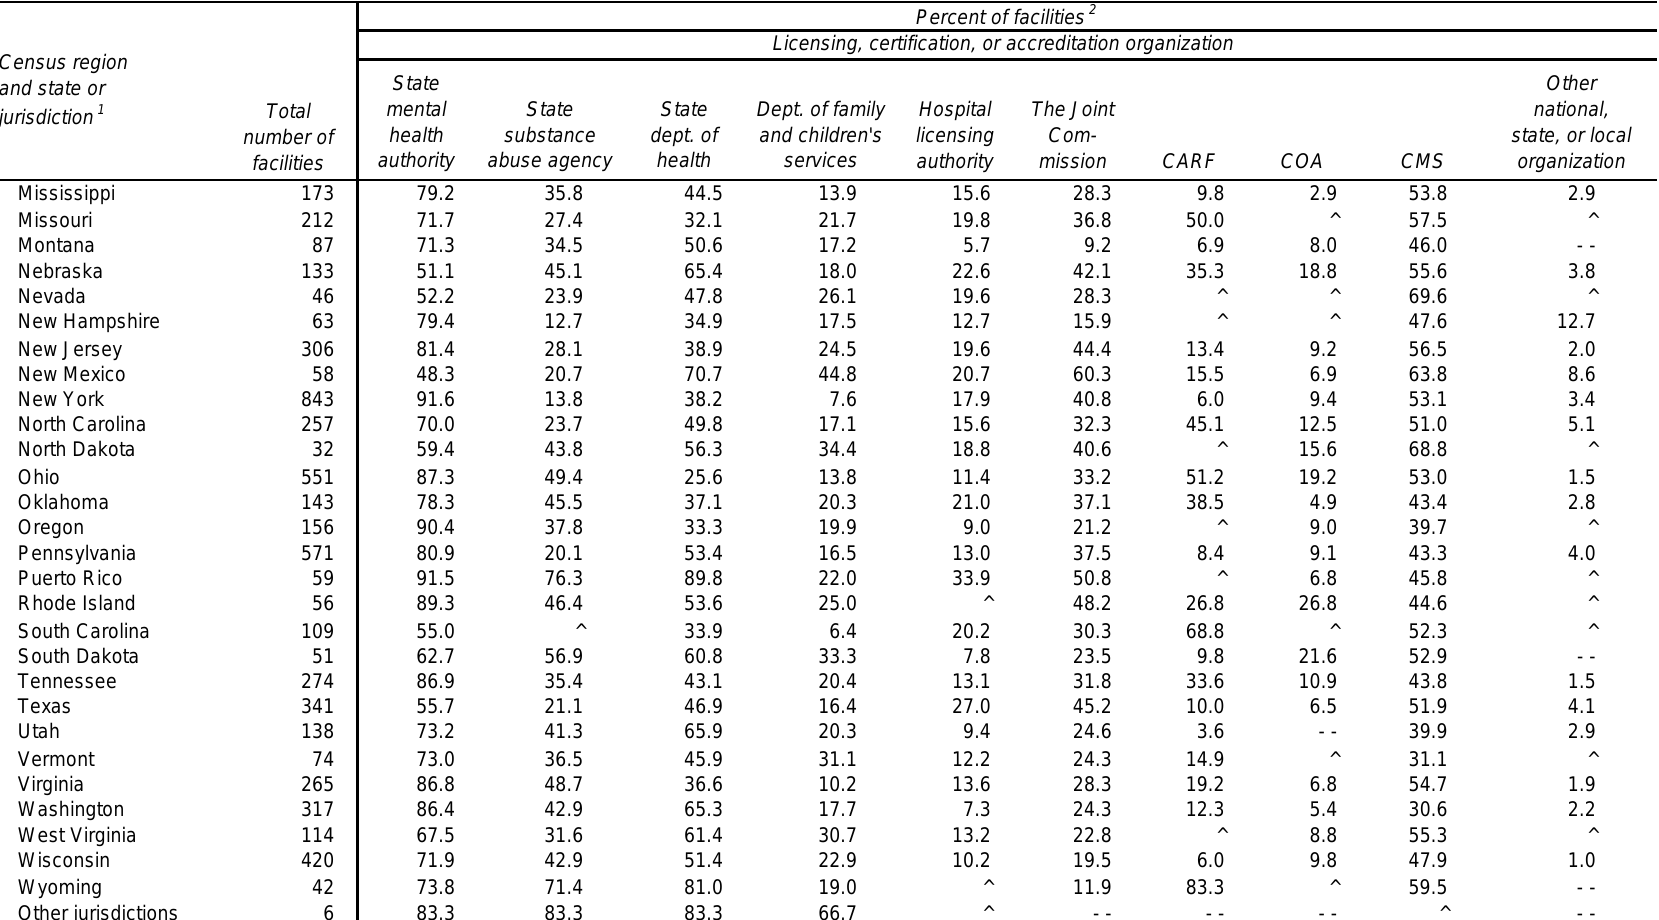
Table 3.14b. Mental health treatment facility licensing, certification, or accreditation, by Census region and state or